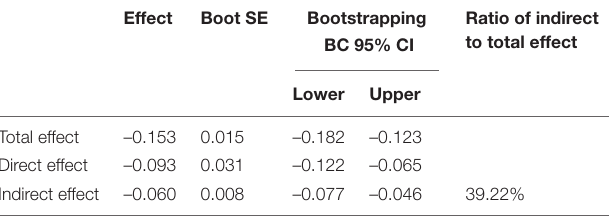
FIGURE 1 | The hypothesized mediation model in which experiential avoidance is associated with life satisfaction directly and indirectly via committed action. Standardized coefficients ( β ) are presented. ** p < 0.01.